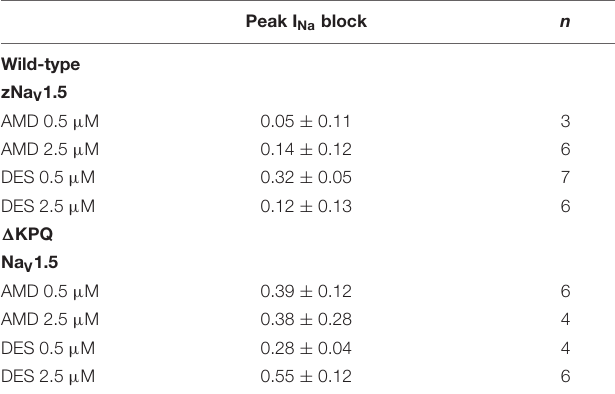
TABLE 2 | Peak I Na block.